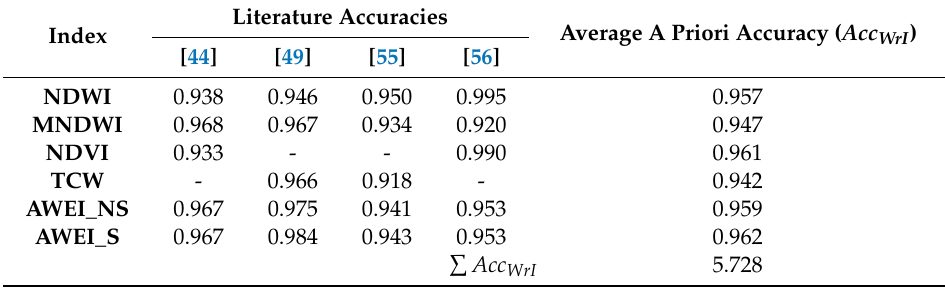
Table 4. Average a priori WrI accuracies for water detection, obtained from the literature, in